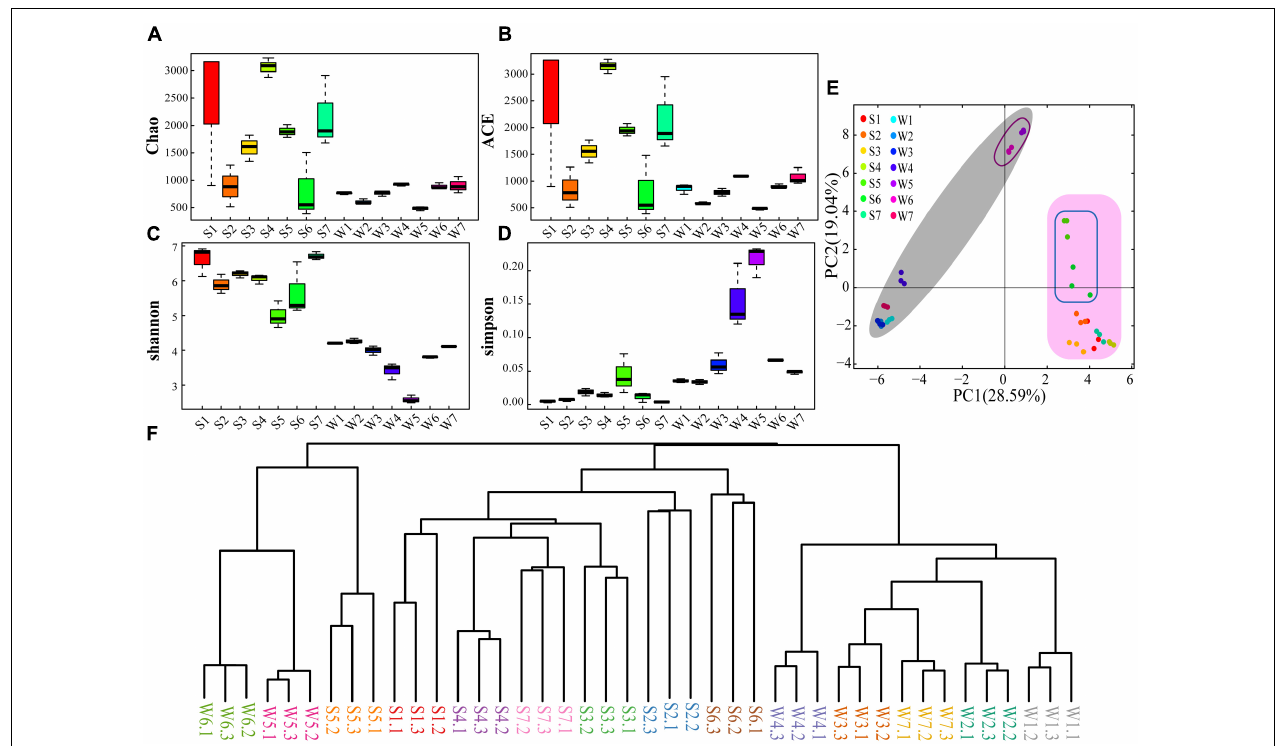
FIGURE 2 | The diversity and phylogenetic structure of community composition. Sampling was performed at different sites for three times. W, Water samples; S, sediment samples. (A) Chao index. (B) ACE index. (C) Shannon index. (D) Simpson index. (E) PCA of the water and sediment samples based on the analysis of OTUs. (F) Bray-Curtis cluster tree of the water and sediment